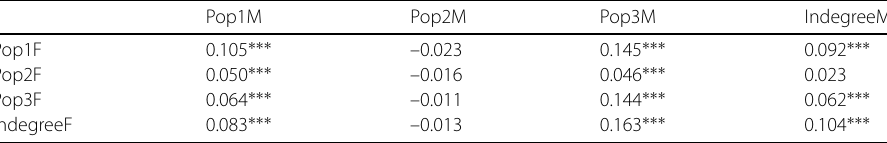
Table 5 Spearman correlation coefficients among centrality indices when females send messages to males Pop1M Pop2M Pop3M IndegreeM Pop1F 0.105 ∗∗∗ –0.023 0.145 ∗∗∗ 0.092 ∗∗∗ Pop2F 0.050 ∗∗∗ –0.016 0.046 ∗∗∗ 0.023 Pop3F 0.064 ∗∗∗ –0.011 0.144 ∗∗∗ 0.062 ∗∗∗ IndegreeF 0.083 ∗∗∗ –0.013 0.163 ∗∗∗ 0.104 ∗∗∗